Question: Name the type of graph shown.
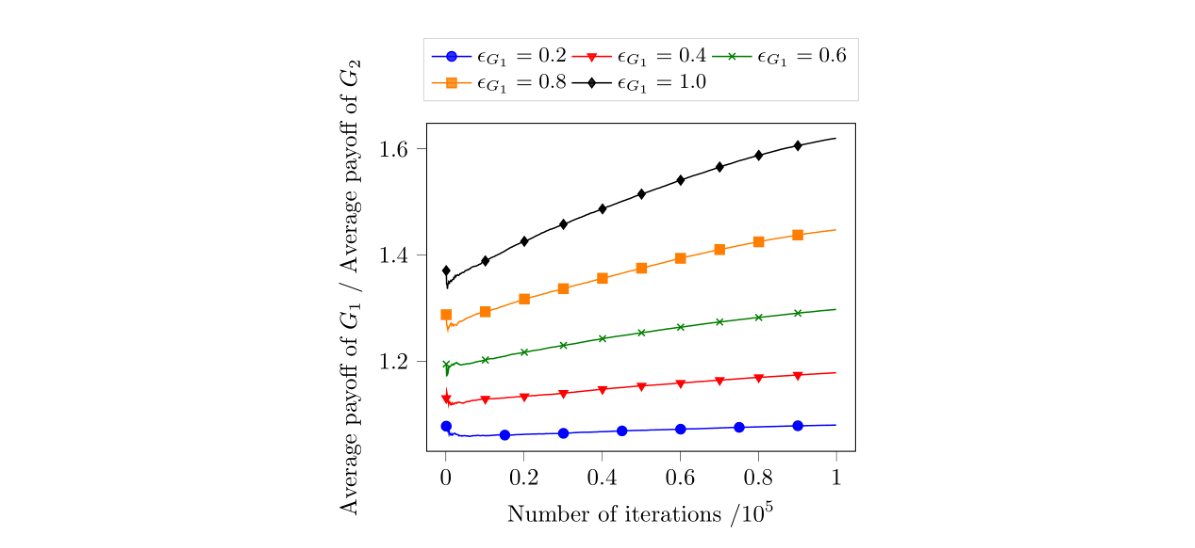
Answer: line